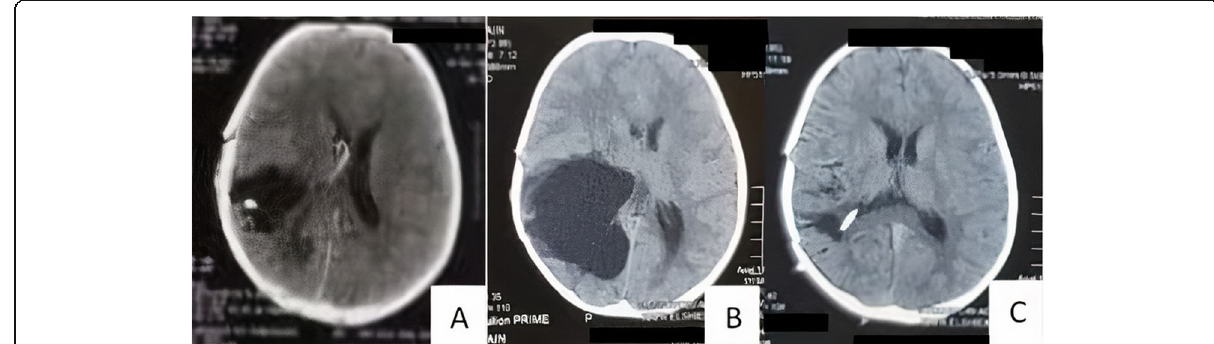
Fig. 5 a CT brain 2 weeks after surgery. b CT brain 5 weeks after surgery. c CT brain after VP